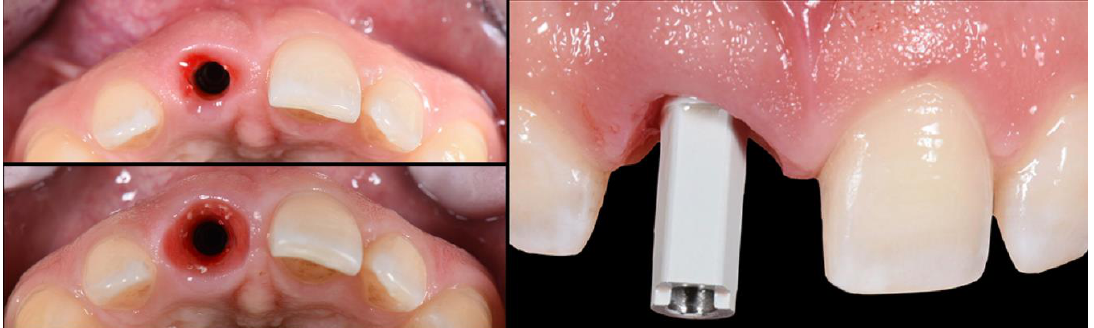
Figure 17. Impression stage. Comparison of soft tissue topography at time of transitional restoration installation and removal 4 weeks later. Digital impression with scan post is taken.